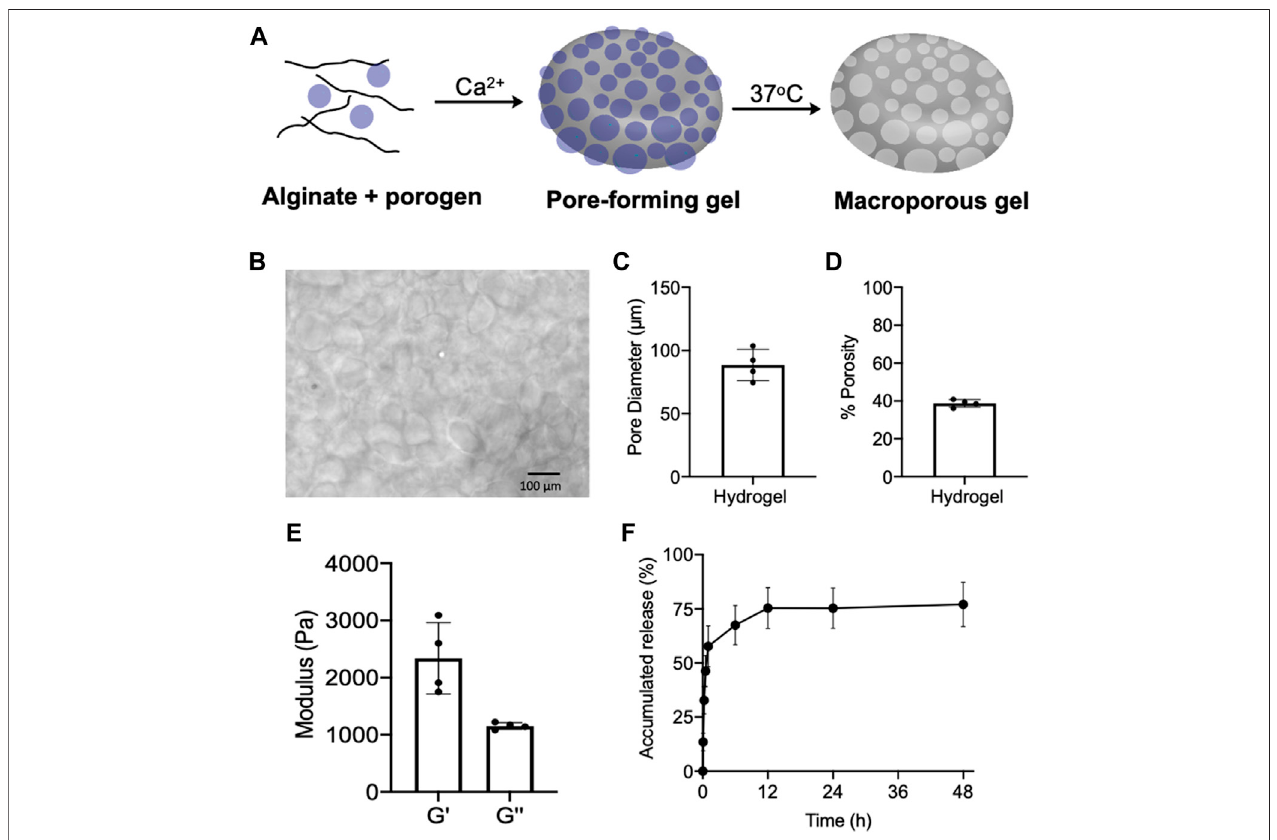
FIGURE2|(A) Schematicillustrationforthefabricationanddegradationofpore-forminggels. (B) Microscopicimagesofformedmacroporousgelsafterimmersing pore-forming gels in PBS at 37 ° C for 6 h. (C) Pore diameter of formed macroporous gels ( n = 4). (D) Porosity of formed macroporous gels ( n = 4). (E) Storage modulus (G ′ ) and loss modulus (G ″ ) of pore-forming gels ( n = 4). (F) Release kinetics of epacadostat from pore forming gels ( n = 4). All the numerical data are presented as mean ± SD.